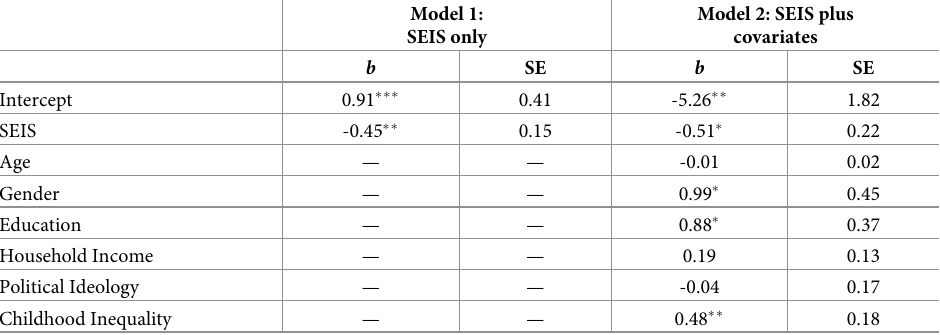
Table 5. Logistic regressions of whether or not the petition was signed onto the SEIS scale, controlling for relevant